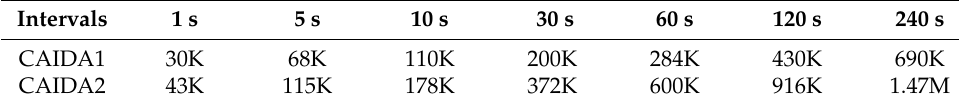
Table 2. The statistics of CAIDA traces (K: thousand, M: million). Intervals 1